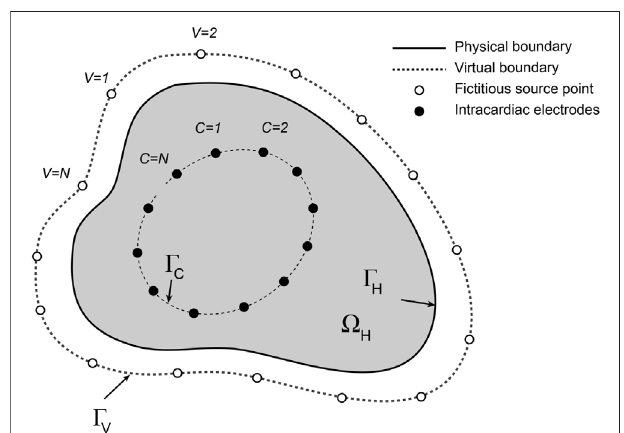
FIGURE 1 | Schematic representation of the intracardiac forward problem. Fictitious electrical sources (open circles) distributed around a virtual boundary Γ V outside the surface Γ H that bounds a heart cavity Ω H generate current fl ux within the domain. This contributes to potentials recorded with electrodes (closed circles) on a basket catheter. The electrodes lie on the open surface Γ C